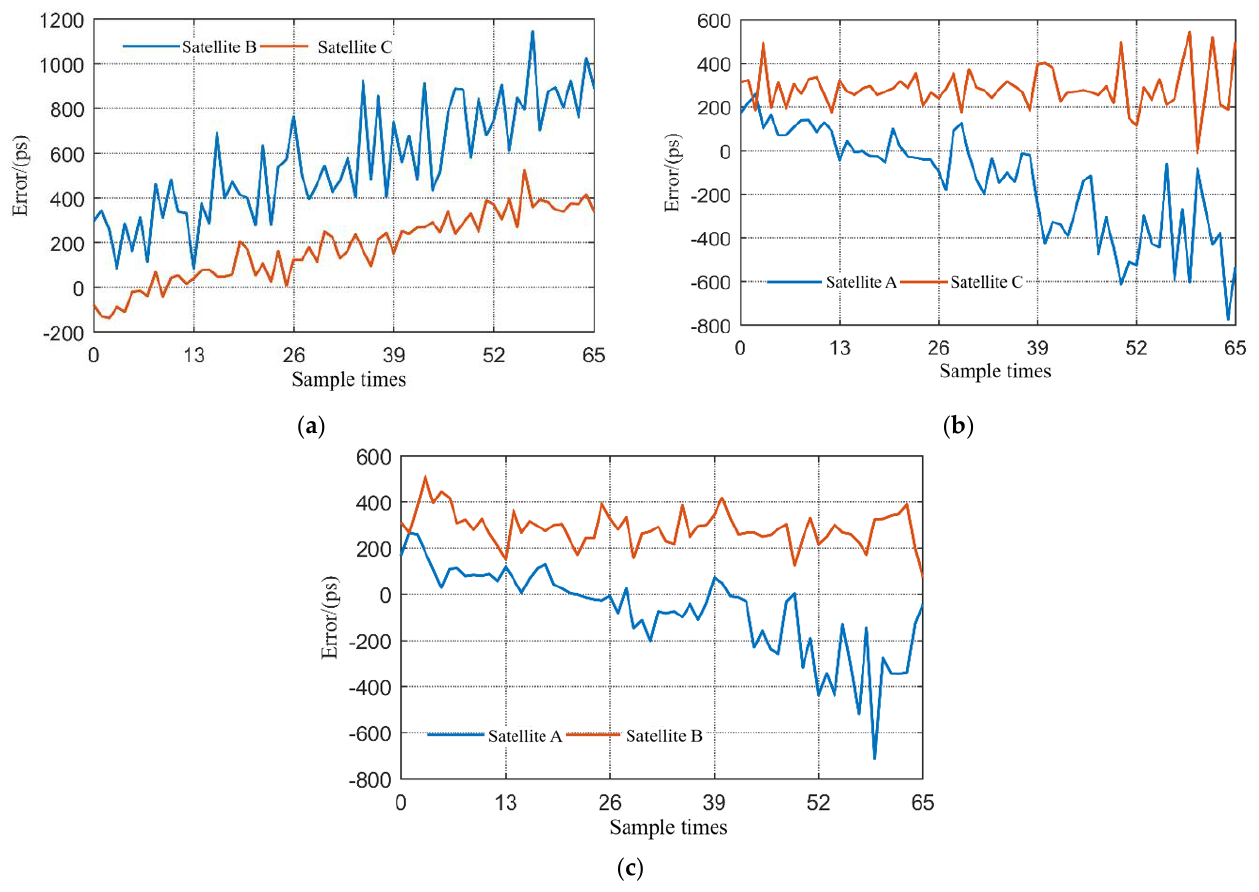
Figure 19. Multi-node clock synchronization experimental results: ( a ) results of node B and C when node A is the master node; ( b ) results of node A and C when node B is the master node; and ( c ) results of node A and B when node C is the master node.